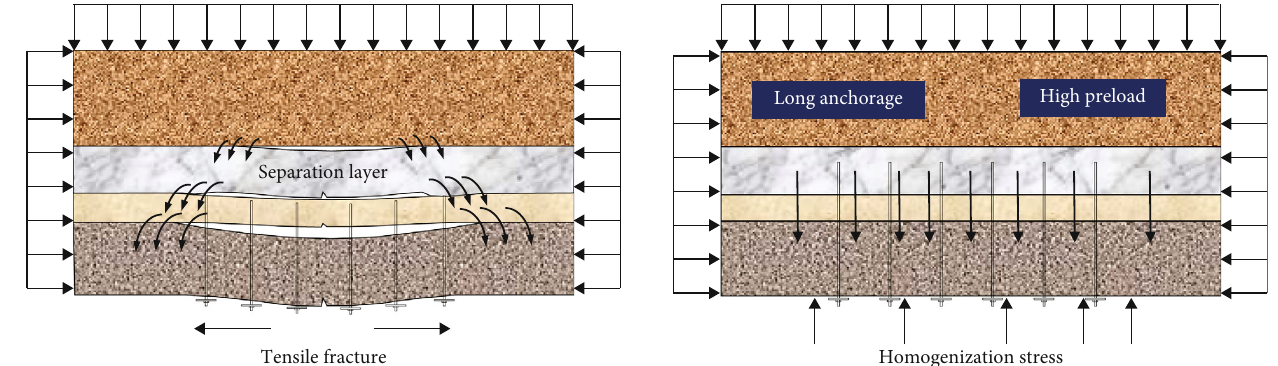
Figure 10: Control principle of high pretightening and long anchorage in coal roadway with composite roof.